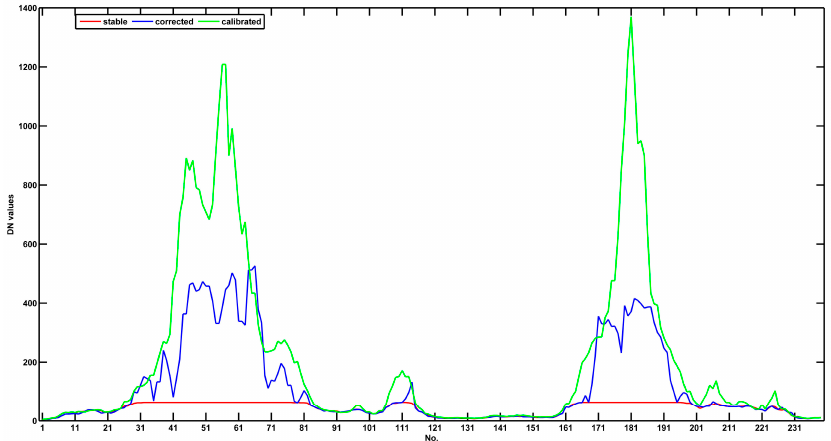
Figure 10. DN value curves in the corrected (blue), 2006 SNL (red) and RCNL (green) images extracted by the straight line (from (40.26°N, 116.04°E) to (38.78°N, 117.57°E), Beijing–Tianjin region).